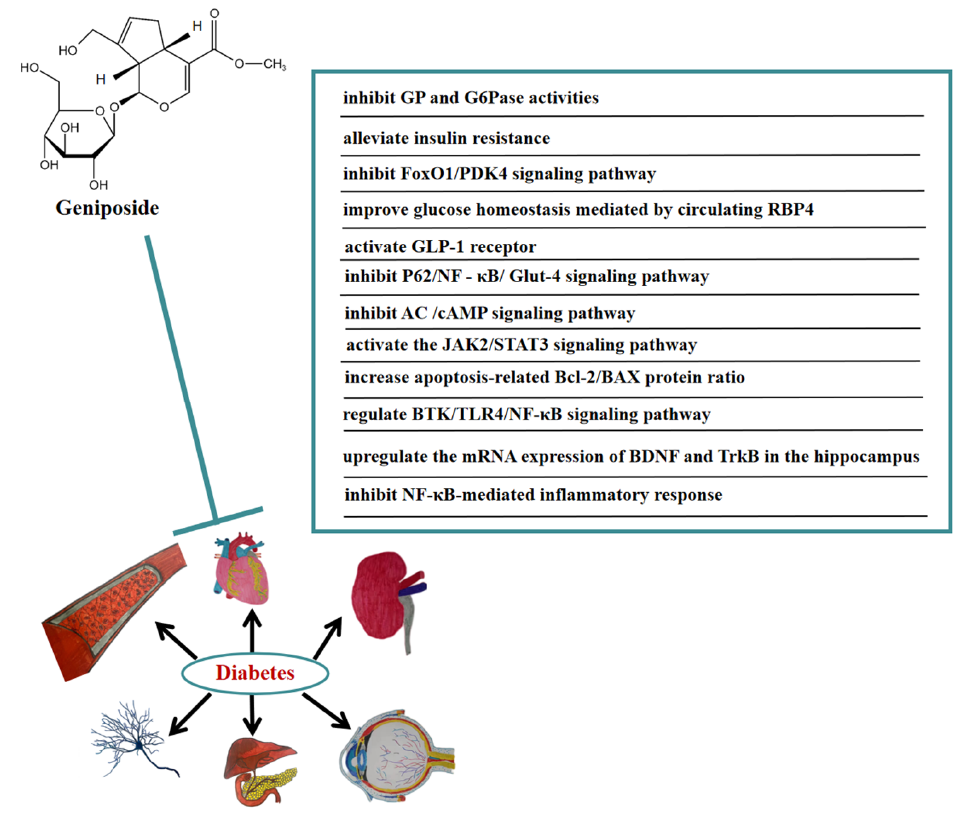
Figure 5. A summary of mechanisms of geniposide on diabetes.